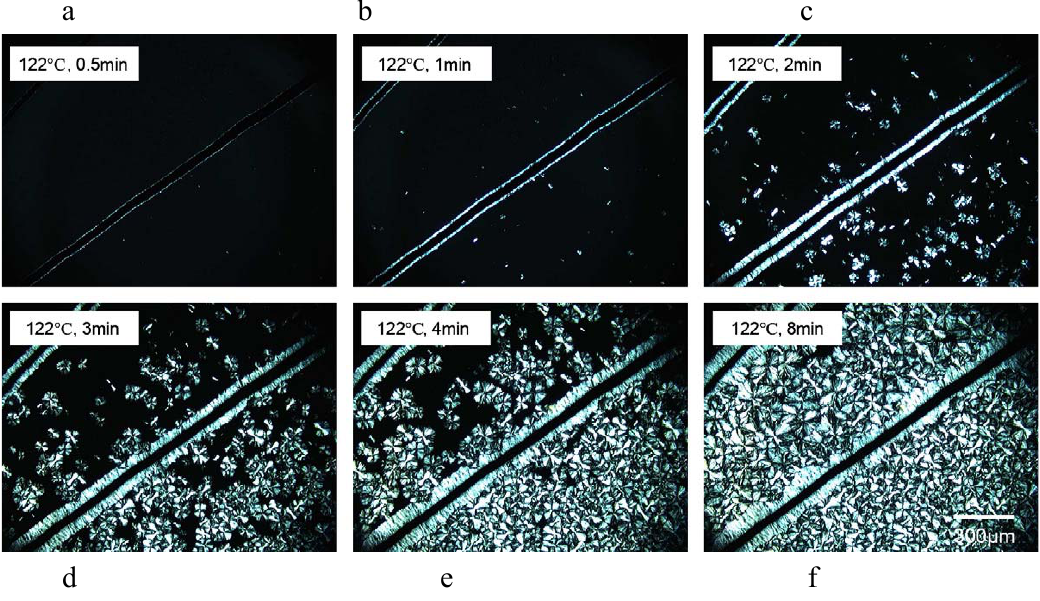
Optical micrographs under cross-polars of transcrystal developments for polypropylene surrounding the carbon fibers at 122 °C for different times: (a) 0.5 min,